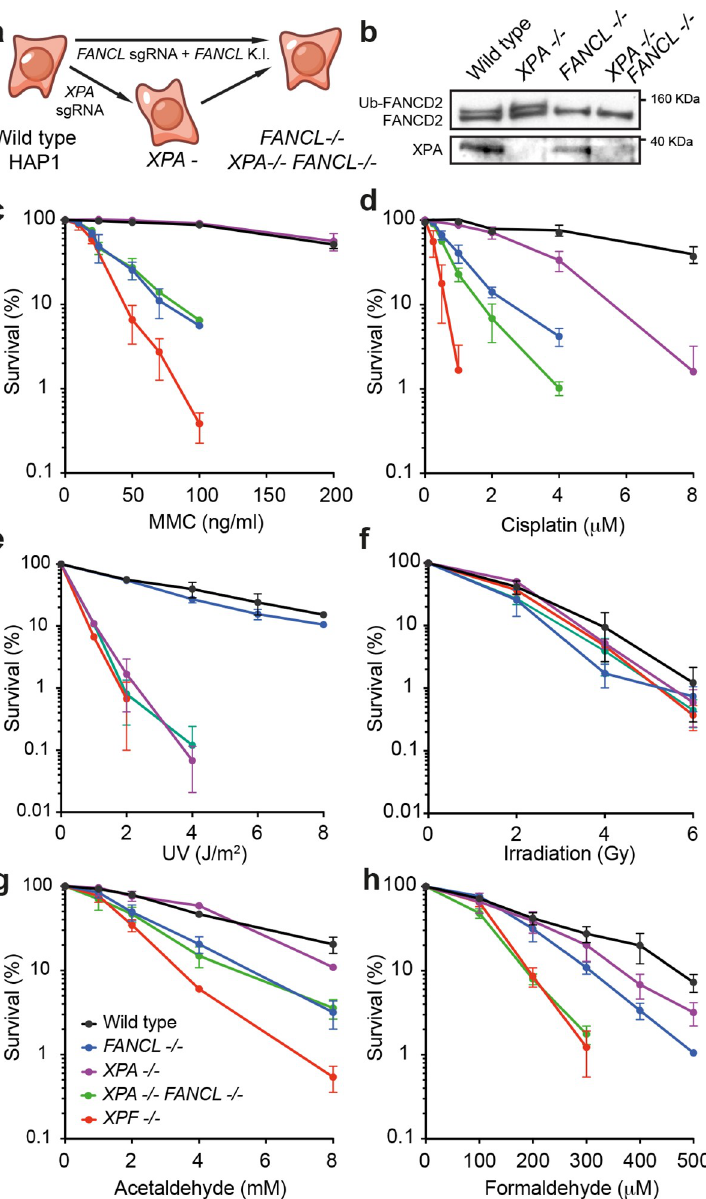
Fig 3. NER and the FA pathway cooperate to protect cells from formaldehyde, an endogenous crosslinking agent. a) Scheme for the isogenic disruption of the FANCL locus in wild type or XPA - HAP1 cells. See S2 Fig for more details. b) Western blots showing lack of FANCD2 monoubiquitination and XPA protein in HAP1 knock out lines. c-h) Survival of HAP1 cells in response to mitomycin C (MMC), cisplatin, UV, irradiation, acetaldehyde and formaldehyde. In c-h , each data point represents the mean of at least two independent experiments, each carried out in duplicate, error bars represent s.e.m..